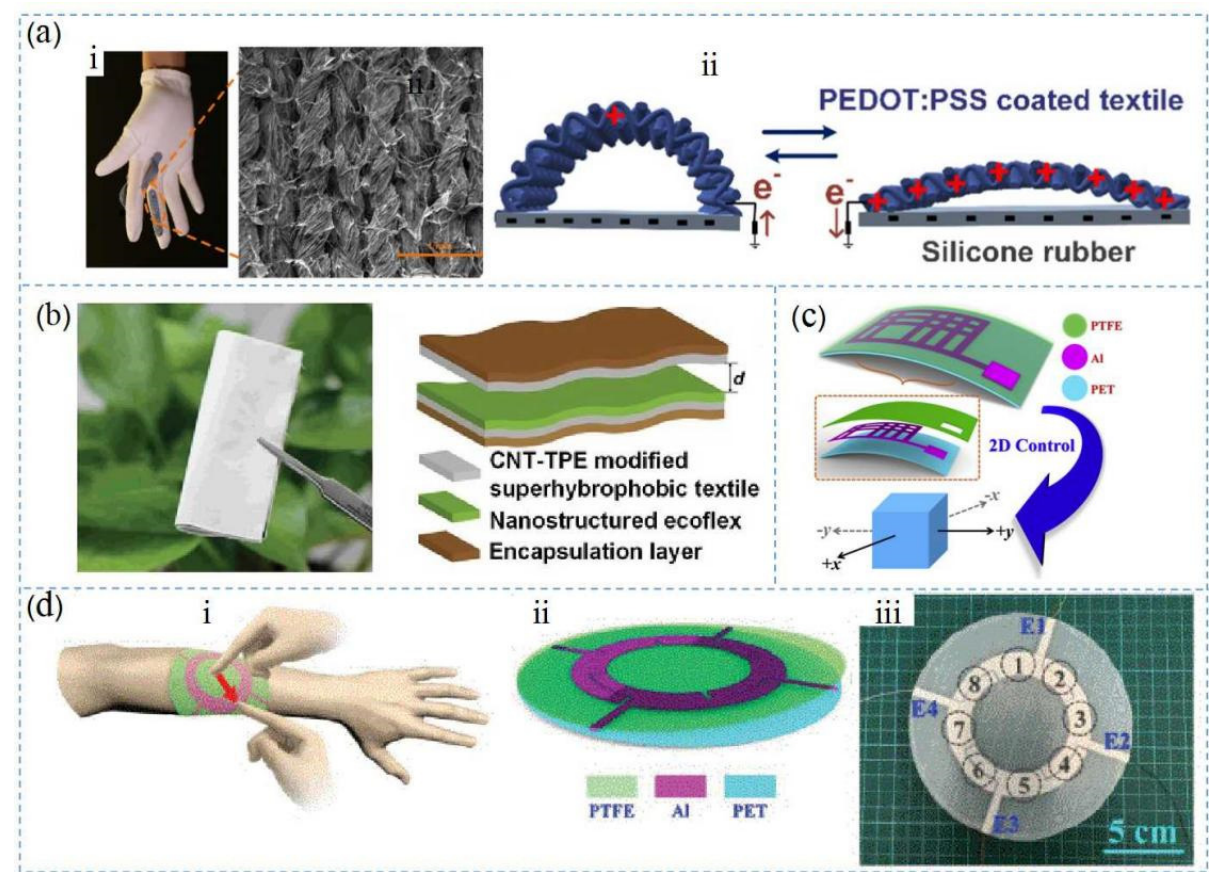
Figure 5. Materials of the wearable TENG: ( a ) material structures of the textiles. Reprinted with permission from ref. [38]. Copyright 2019 Nano Energy; ( b ) material structure of the superhydrophobic textile TENG. Reprinted with permission from ref. [42]. Copyright 2020 Advanced Science; ( c ) mate- rial structure of TENG to control a virtual UAV, Reprinted with permission from ref. [40]. Copyright 2019 Nano Energy; ( d ) material structure of triboelectric patch on a human arm. Reprinted with permission from ref. [104]. Copyright 2020